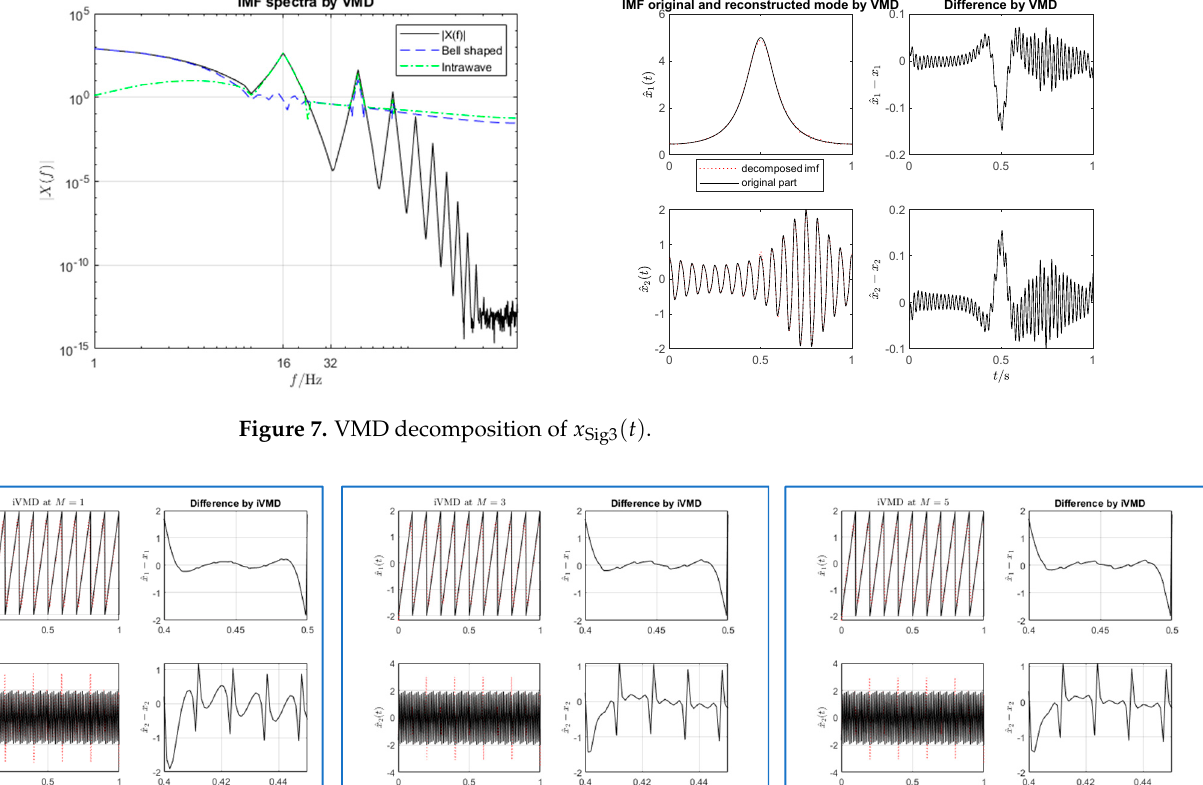
Figure 8. iVMD decomposition of x Sig4 ( t ) run via iVMD. The algorithm iVMD is run at M = [ 1;3;5 ]